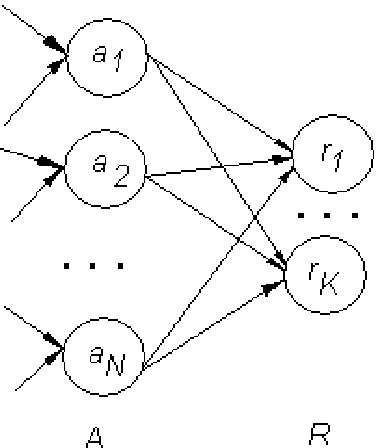
Figure 9. Connections between A and R layers.